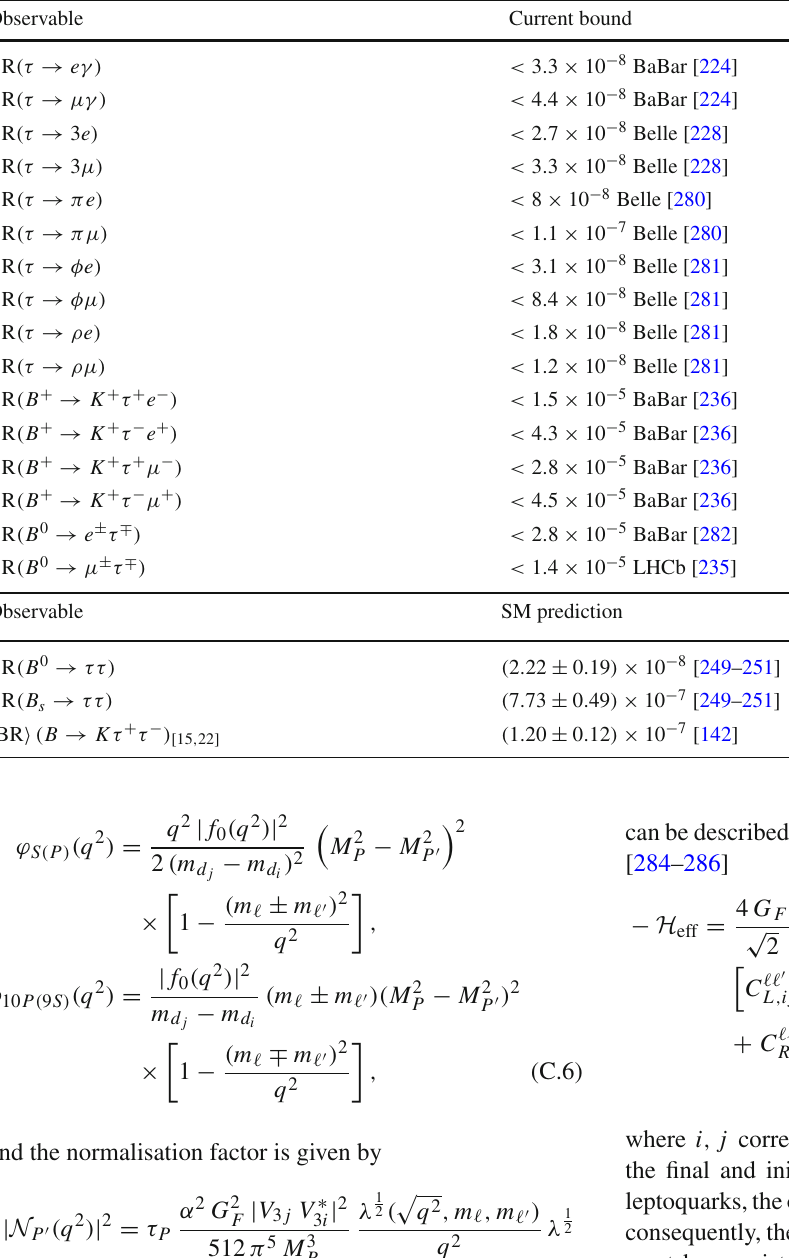
Table 14 Observables for which Belle II will improve on current experimental sensitivities. The SM predictions are obtained using flavio [199], unless otherwise stated Observable Current bound Belle II